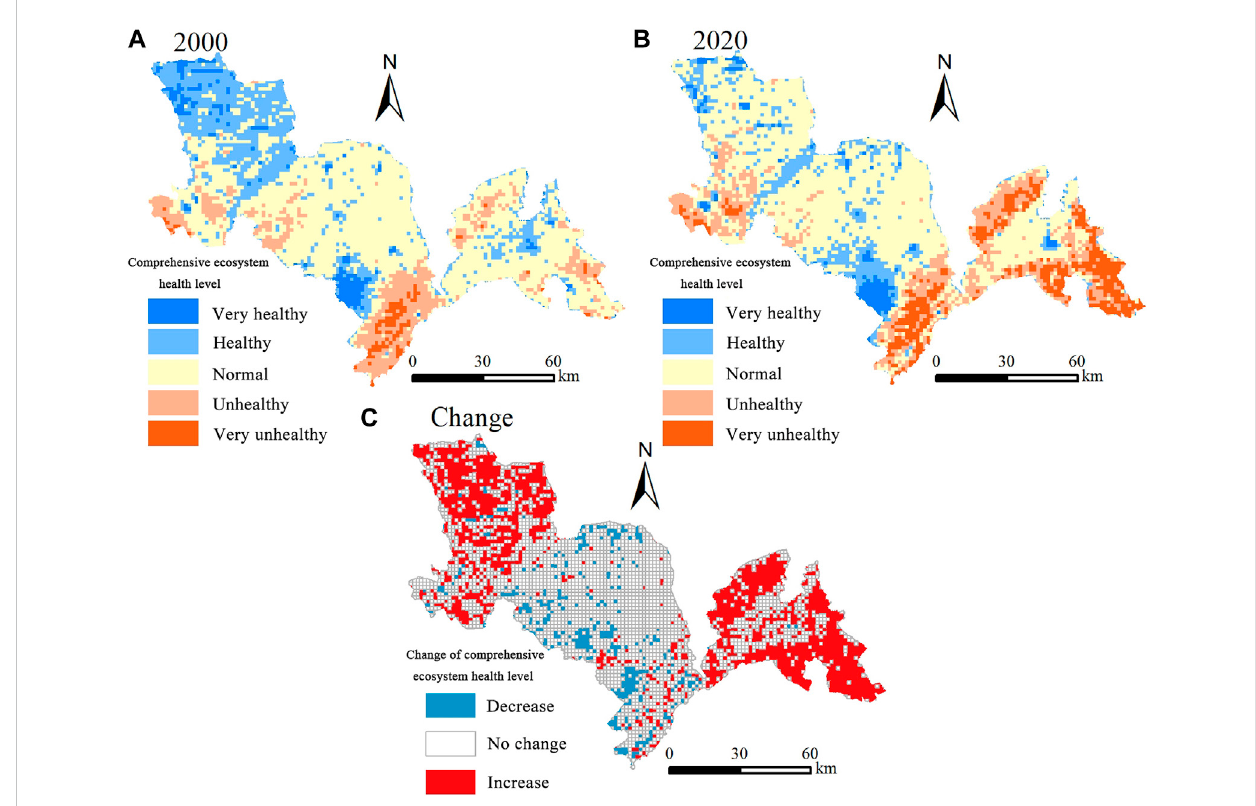
FIGURE 7 The comprehensive ecosystem health level in (A) 2000 and (B) 2020, and (C) its temporal